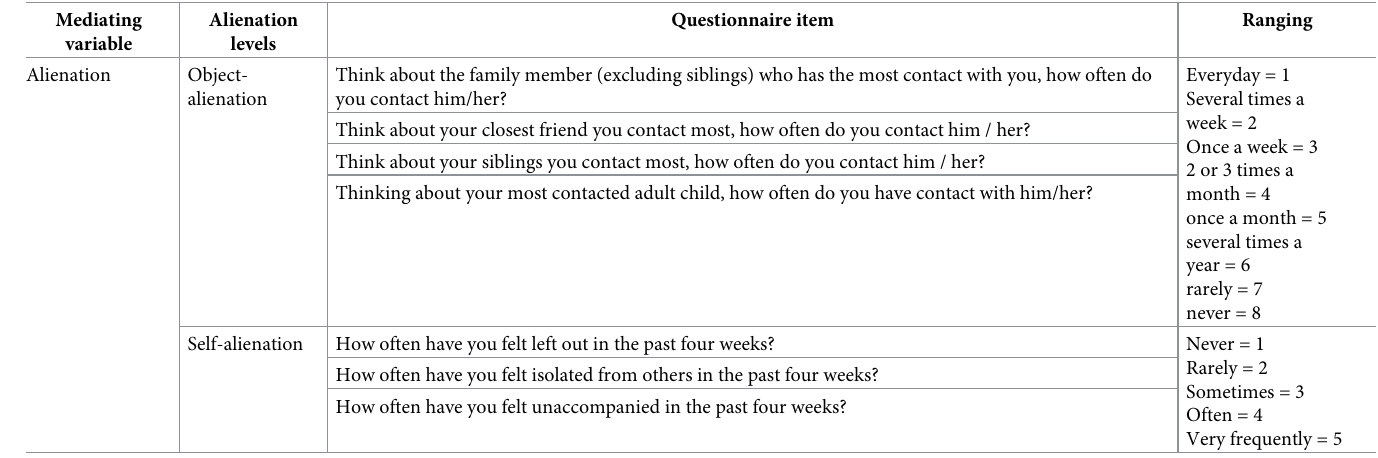
Table 1. Operational definition of alienation. The alienation contains two levels: object-alienation and self-alienation and a total of 7 questions remained. Mediating